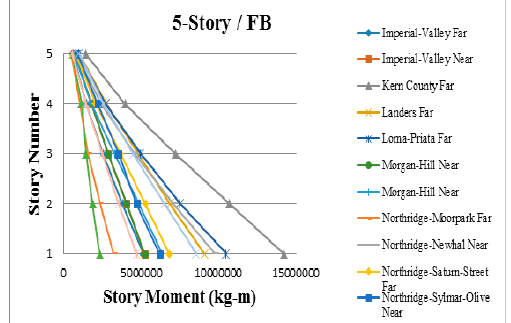
Figure A13. Peak story moments for 5-story fixed-base building.